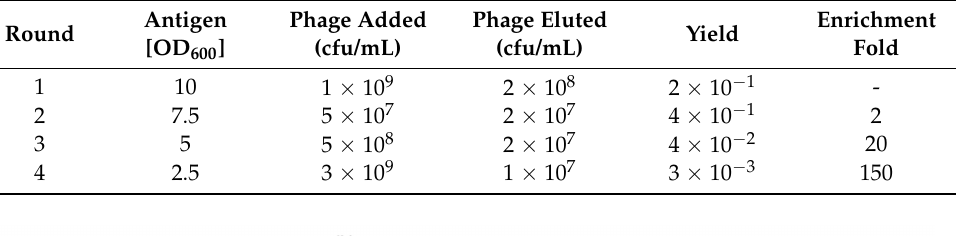
Table 3. Summary of biopanning round selection. Yield = Phage eluted/Phage added. Round